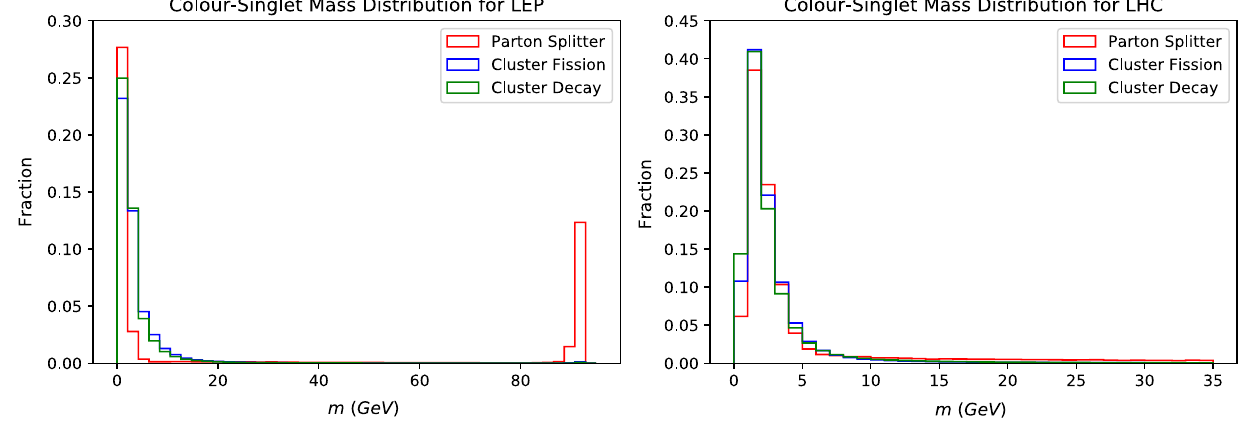
Fig. 4 Mass distributions for colour-singlet systems immediately before the Parton Splitter, Cluster Fissioner, and Cluster Decayer steps in LEP and LHC Minimum Bias events. Note the different mass axis scales